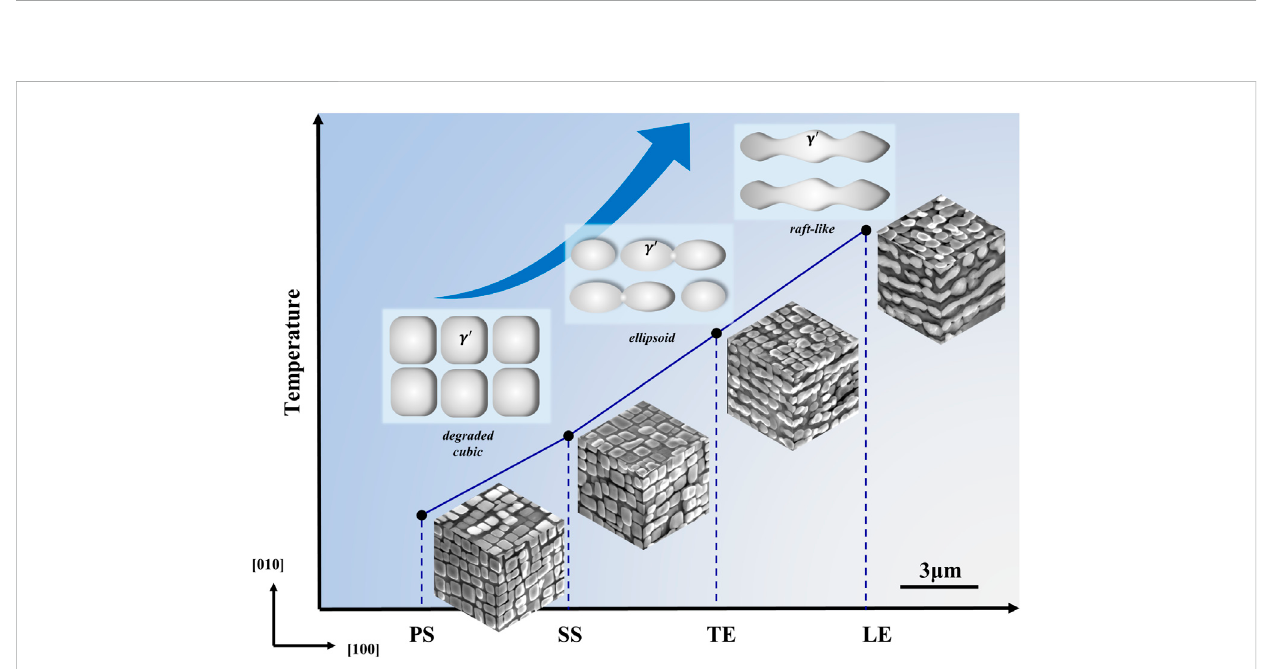
FIGURE 9 Evolution of the microstructure of the serviced DZ125 blade with temperature at S4 and the schematic of the evolution process of γ ′ precipitates.